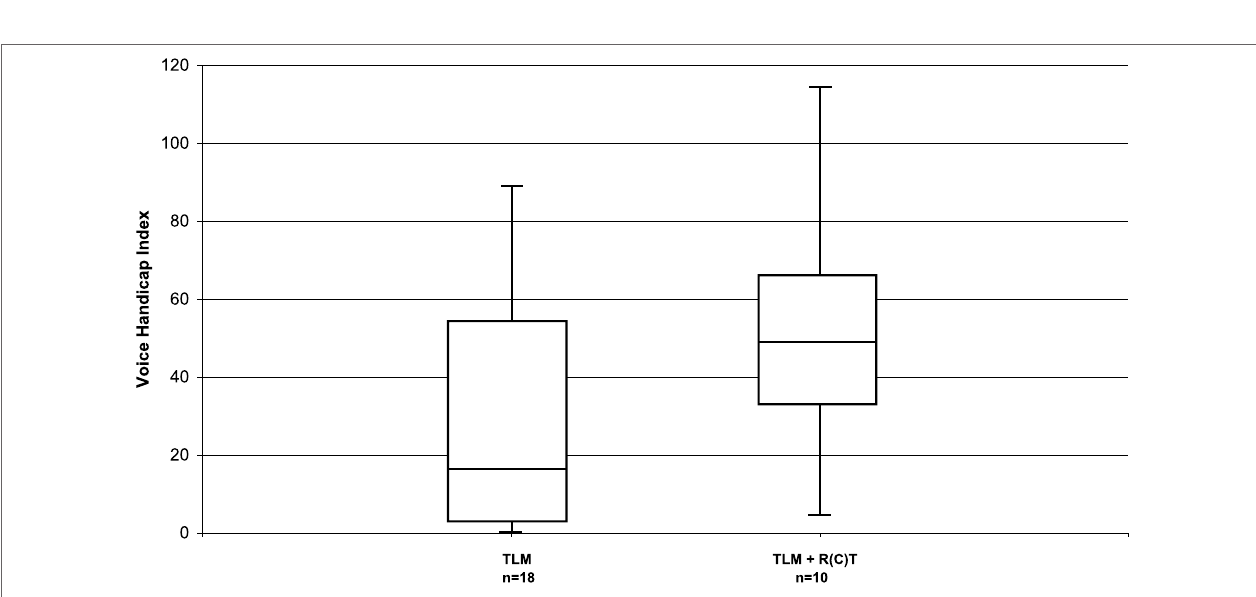
FigUre 1 | Distribution of the MDADI composite score in long-term survivors after TLM ( n = 19) and after TLM + adjuvant RT ( n =